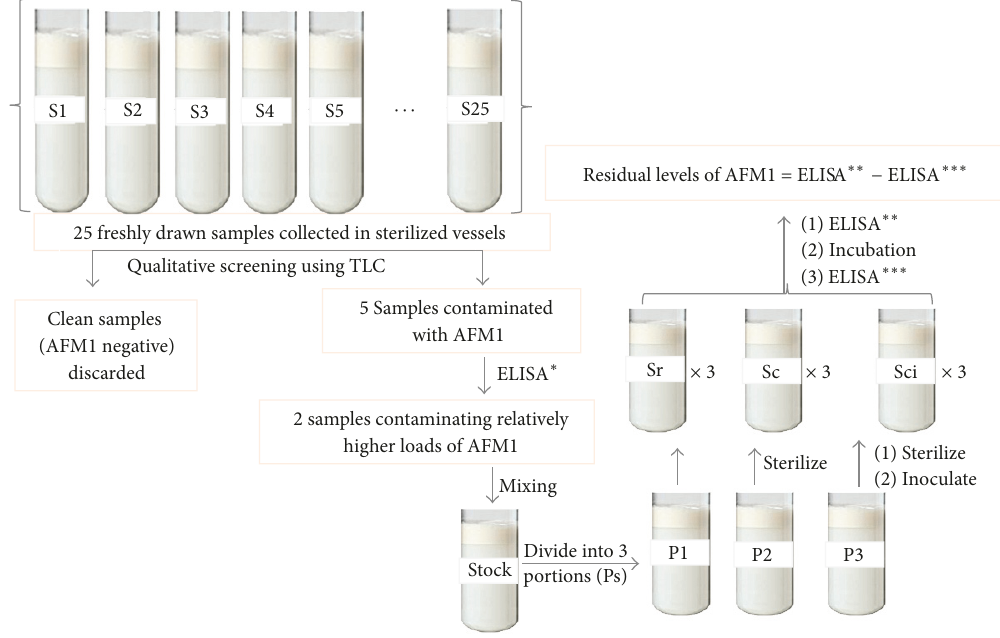
Figure 1: Schematic of preparation and treatment of milk samples (Sr, Sc, and Sci) for AFM1 reduction during incubation at ergo fermentation